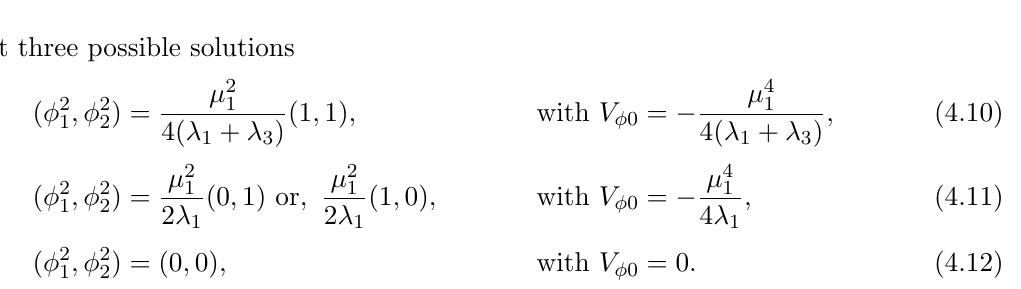
Figure 1 . The D 4 -symmetric potential in eq. (4.4) for di(cid:11)erent values of (cid:21) 3 =(cid:21) 1 . In the upper left panel ( (cid:21) 3 =(cid:21) 1 = 1), the potential is not bounded from below. In the upper right panel (cid:0) ( (cid:21) 3 =(cid:21) 1 = 1 = 2), the potential has four minima at ( (cid:30) 1 ; (cid:30) 2 ) = 1 (cid:0) ( (cid:21) 3 =(cid:21) 1 = 0), the potential has in(cid:12)nite minima connected by an SO(2) symmetry. In the lower right panel ( (cid:21) 3 =(cid:21) 1 = 1), the potential has four minima at ( (cid:30) 1 ; (cid:30) 2 ) = 1